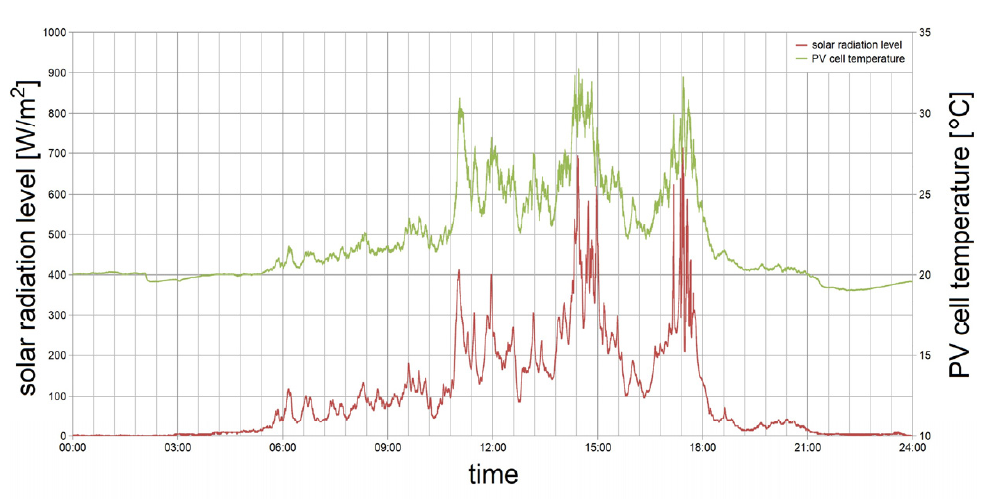
Figure 12. λ and T c for 19 June.